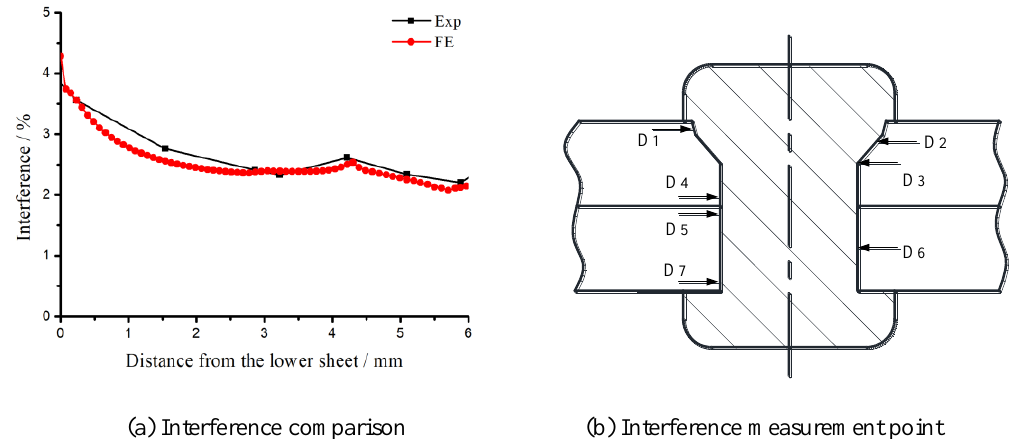
Figure 15. Interference condition between experimental and simulation. ( a ) Interference comparison; ( b ) Interference measurement point. The points D1 - D6 are the number of measurement points.